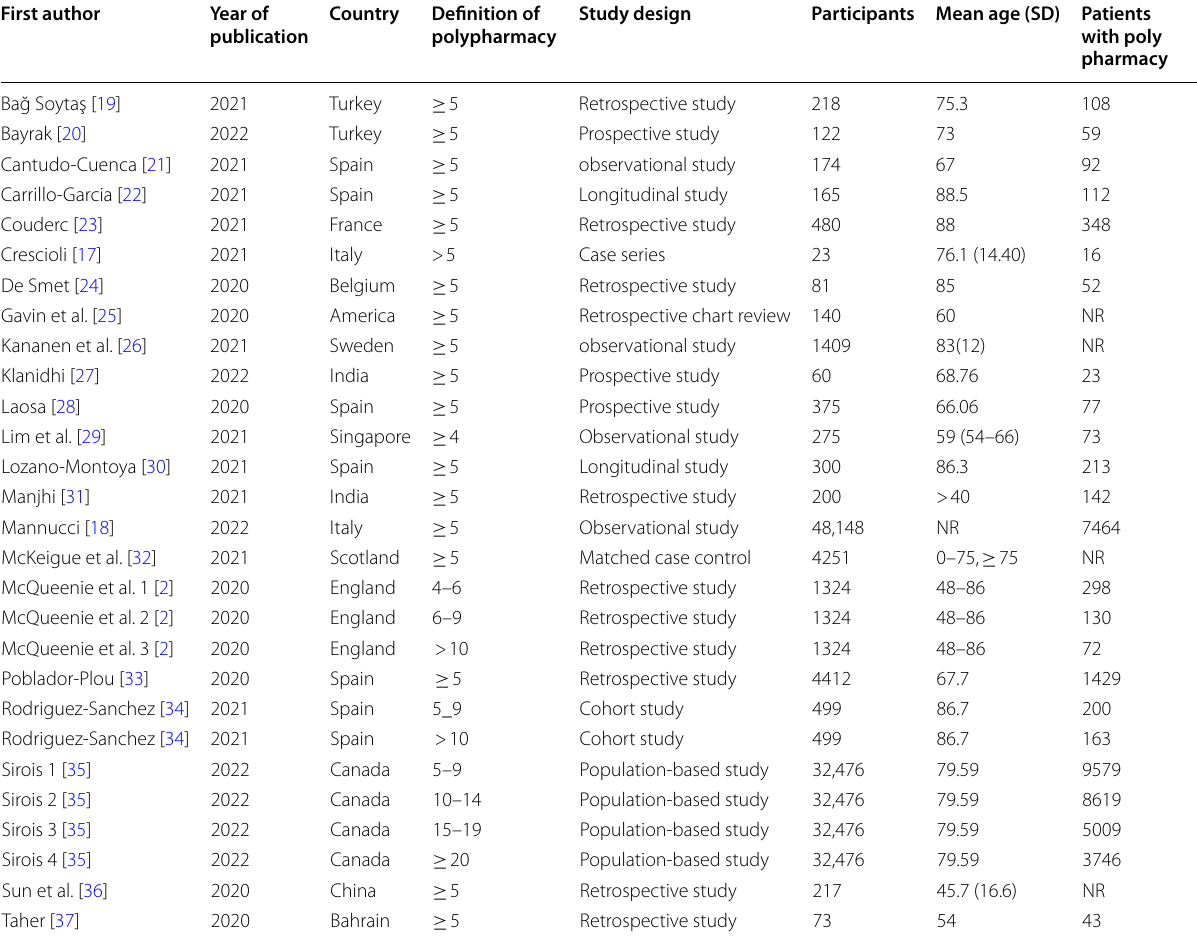
Table 2 Characteristics of the selected